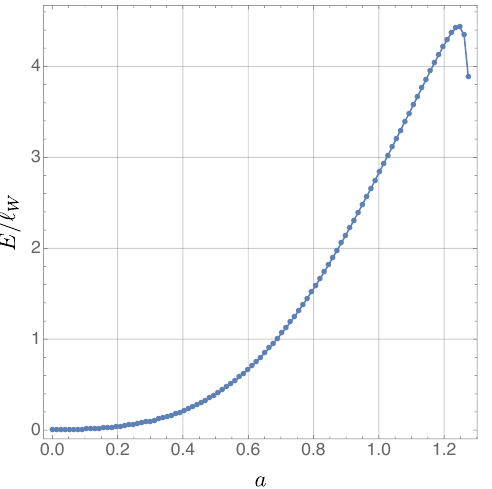
Figure 17 . C max as a function of a for the T = 0 compact case.